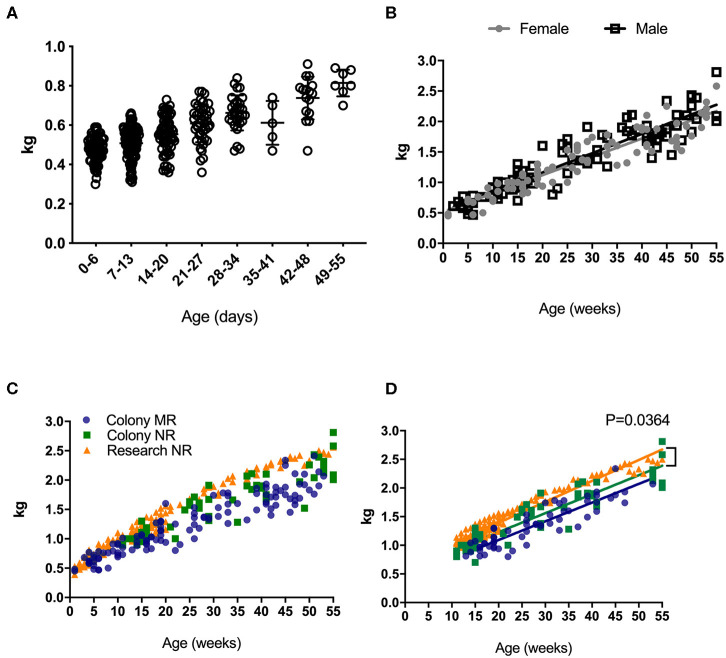
Weights of pediatric rhesus macaques. Weights were plotted over the first 55 days for all pediatric groups including Colony MR and Colony NR, as well as Research NR animals (A). Weights were stratified by sex in colony animals through ~1 yr of age (B). Weights were plotted for groups of Colony MR (blue circles), Colony NR (green squares) and Research NR (orange triangles) animals (C). Linear regression of weights were plotted in each group of animals from Panel C after normalizing for age and slopes were compared by ANCOVA; P < 0.05 was considered significant (D).